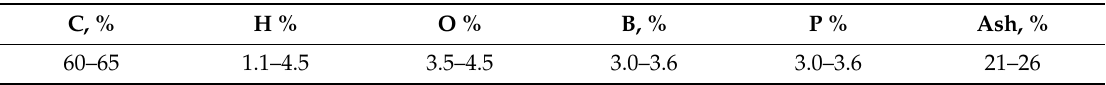
Table 2. Chemical composition of UTM-8-1s (product model [16]) carbon fabric.